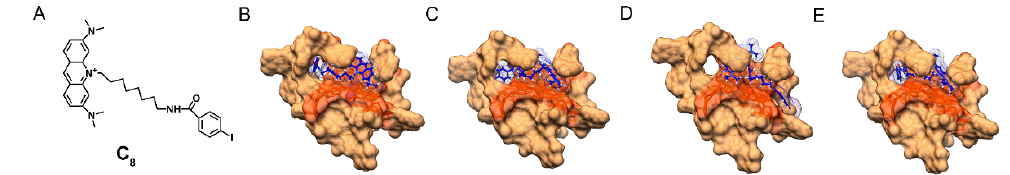
Figure 4. ( A ) Chemical structure of the acridine derivative C 8 . ( B – E ) Computational models of complex C 8 / KRAS 22-RT generated by molecular docking after energy minimization. The figures ( B – E ) depicted conformers obtained with different binding free energies, − 9.32, − 7.24, − 9.17 and − 8.40 kcal/mol, respectively. G4 structure is depicted as a light orange surface with the 5 ′ tetrad highlighted in darker orange. C 8 is represented in blue. Adapted from ref. [81].